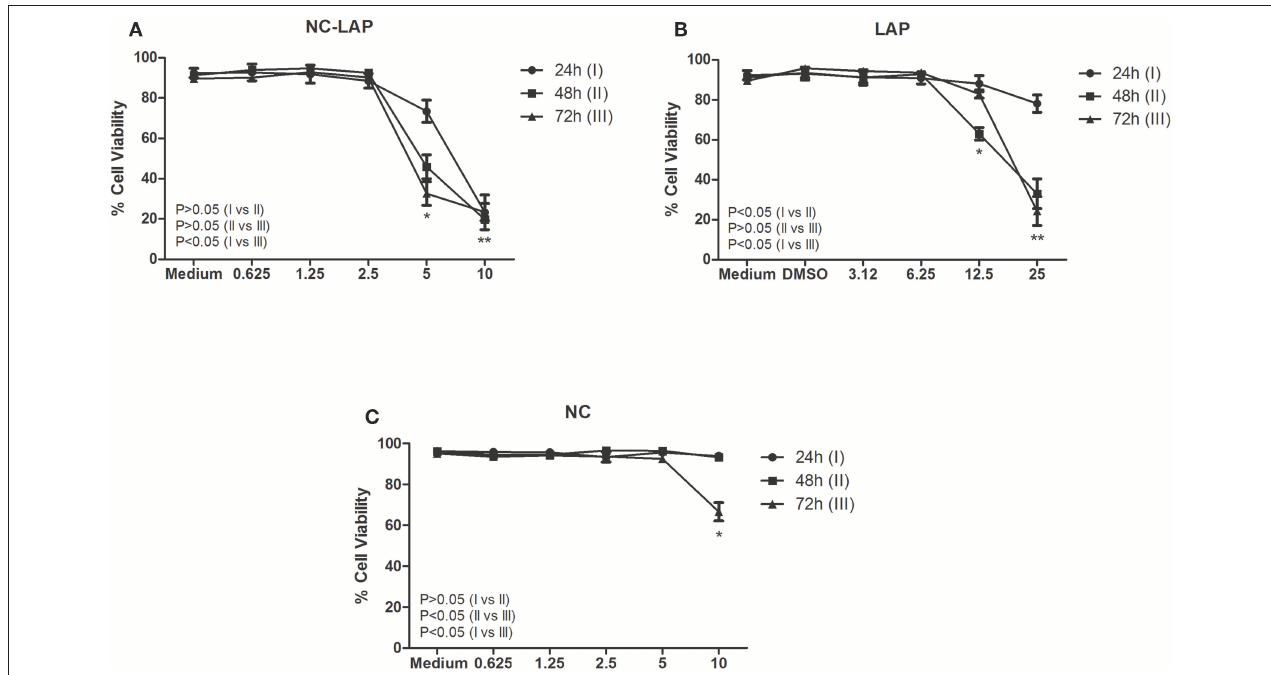
FIGURE 2 | NC-LAP (A) , LAP (B) , and NC (C) effect on T24 cells viability assessed by flow cytometry. Cells were treated with Lapatinib (LAP) at concentrations of 3.12, 6.25, 12.5, and 25 µ M, with Lapatinib-loaded nanocapsules (NC-LAP) at concentrations of 0.625, 1.25, 2.5, 5, and 10 µ M and with relative volume of these concentrations of blank nanocapsules (NC) for 24, 48, and 72h. The data are expressed as means ± SEM of three independent experiments. Two-way ANOVA with Tukey post-hoc was used to analyze statistical significance. (*) represents the significant difference between the different concentrations. The P -value represents the significant difference between treatment times. The differences were considered significant at P <